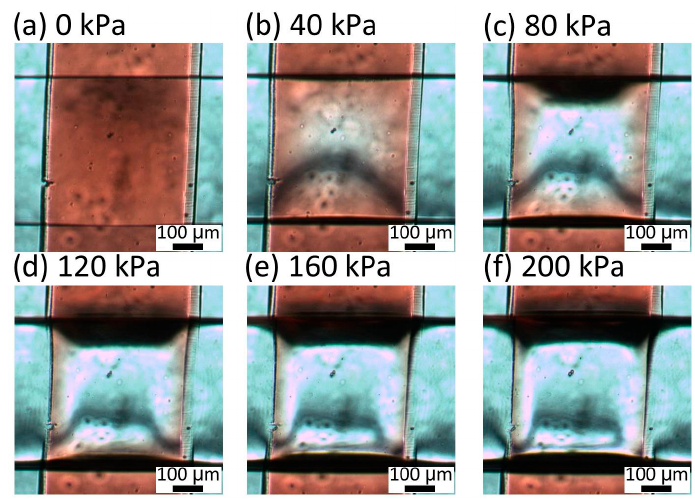
Figure 9. Center of intersection between the two microchannels of the microvalve with a 80- μ m-thick membrane under pressures of ( a ) 0; ( b ) 40; ( c ) 80; ( d ) 120; ( e ) 160; and ( f ) 200 kPa.